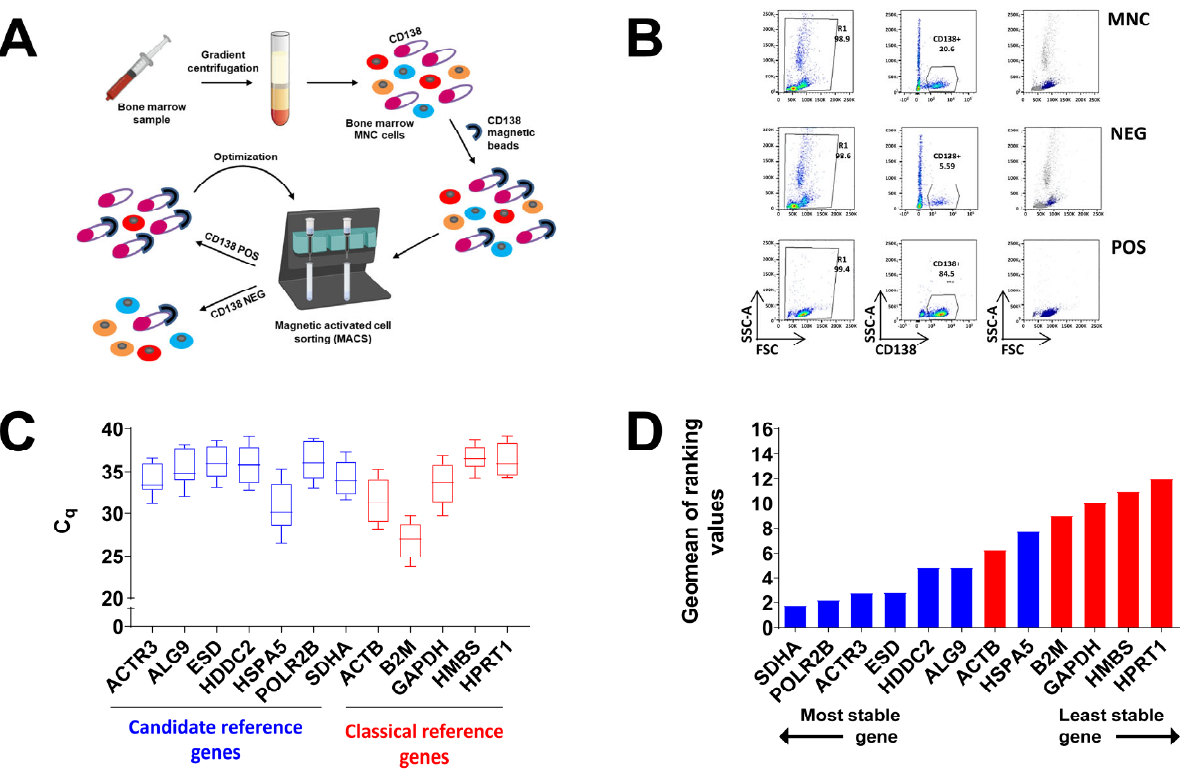
Figure 3. Distribution of expression levels and stability analysis of candidate and “classical” reference genes in AL patients and controls. ( A ) Scheme of immunomagnetic separation of CD138 + cells from bone marrow aspirate. MNC: mononuclear cells. CD138 POS: CD138 + fraction. CD138 NEG: CD138 - fraction. ( B ) Pseudo ‐ color dot plots of flow cytometry analysis of CD138 + cells in MNCs as well as negative and positive fractions after the first or second round of purification of a representative patient. ( C ) Distribution of quantification cycle (C q ) values of candidate reference genes ( n = 7, in blue) and the “classical” reference genes ( n = 5, in red) across all the study subjects. Horizontal lines denote median value, lower and upper extremities of boxes denote 25th and 75th percentiles, and lower and upper whiskers denote minimum and maximum values, respectively. ( D ) Stability ranking of candidate reference genes (blue) and “classical” reference genes (red) based on the geomean of ranking values determined by RefFinder across all the study